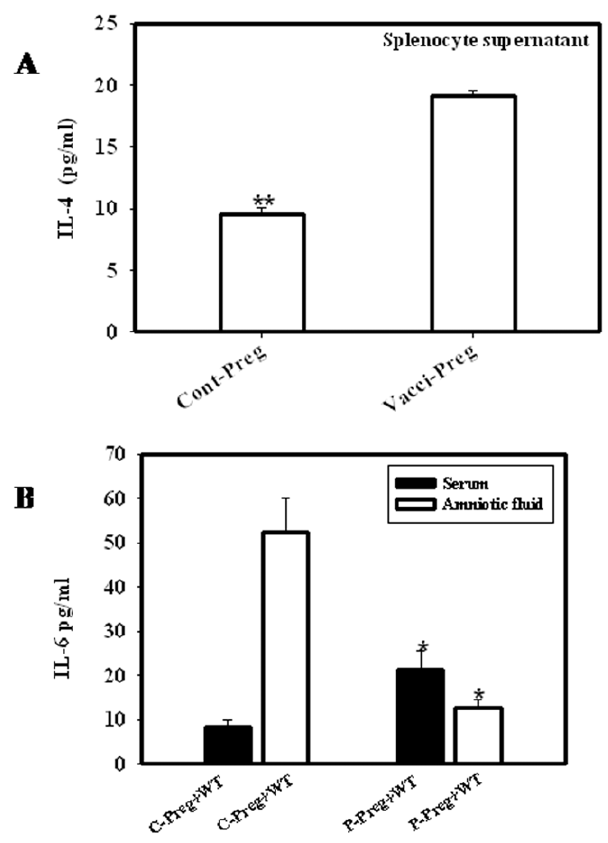
Figure 7. Th2 cytokine levels were higher in vaccinated than unvaccinated pregnant mice. Vaccinated and unvaccinated mice were sacrificed and checked for the cytokine profile. IL-4 was significantly more in vaccinated mice as compared to the unvaccinated mice (A) Levels of Serum IL-6 was enhanced in vaccinated mice but reverse was observed in case of the amniotic fluid of vaccinated and unvaccinated mice (B). Data shows the representative of three independent experiments performed. * p , 0.05, ** p , 0.001(Student ‘‘t’’ test).